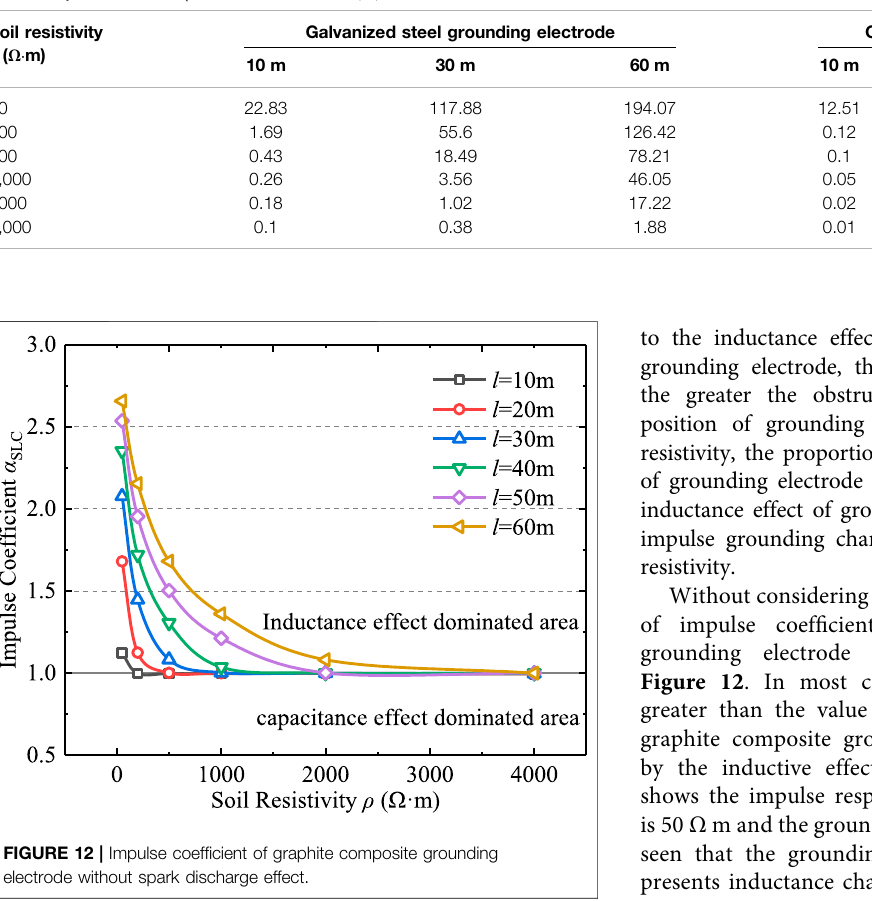
TABLE 4 | In fl uence rate η L of inductance effect (%).